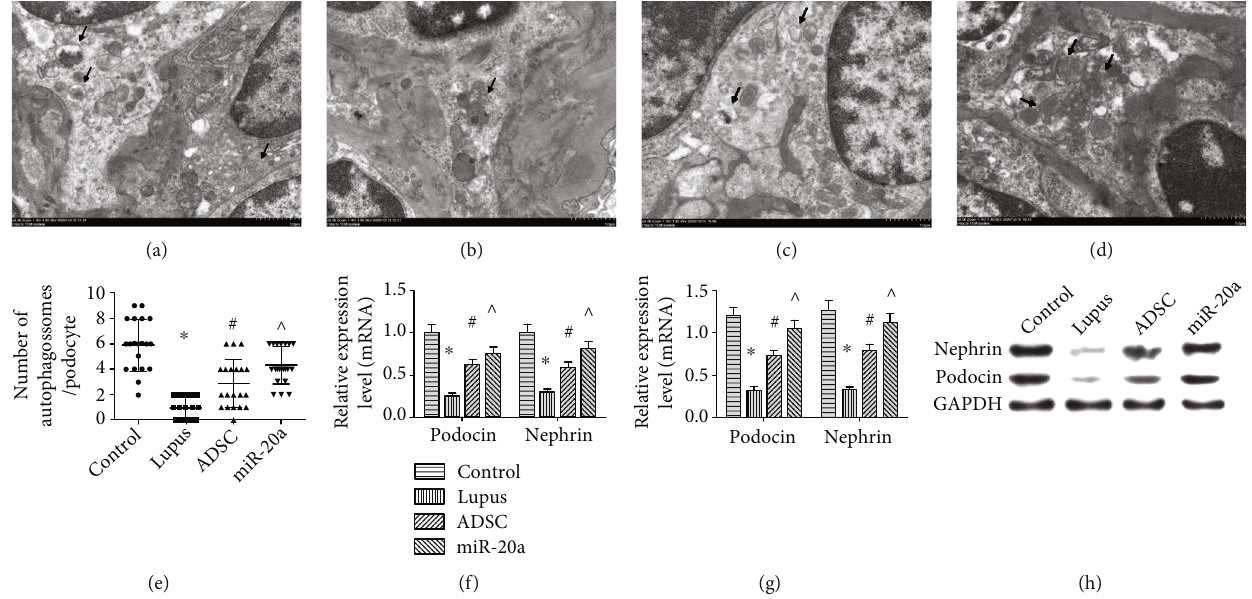
Figure 4: E ff ect of miR-20a-ADSC/ADSC treatment on the podocyte of di ff erent groups. (a – d) Transmission electron micrograph showing autophagosomes (arrows) in the podocytes from the normal control (a), lupus (b), ADSC (c), and miR-20a (d) groups (8,000x). (e) Number of autophagosomes per podocyte. (f) Nephrin and podocin mRNA relative expression levels. (g) Nephrin and podocin relative protein expression levels. (h) Western blot analysis of nephrin and podocin expression in di ff erent groups. The data are expressed as the mean ± SD . ∗ P < 0 : 05 vs. control group; # P < 0 : 05 vs. lupus group; ^ P < 0 : 05 vs. ADSC group. Control: normal control group; lupus: lupus group; ADSC: adipose-derived stem cell group; miR-20a: miR-20a-ADSC